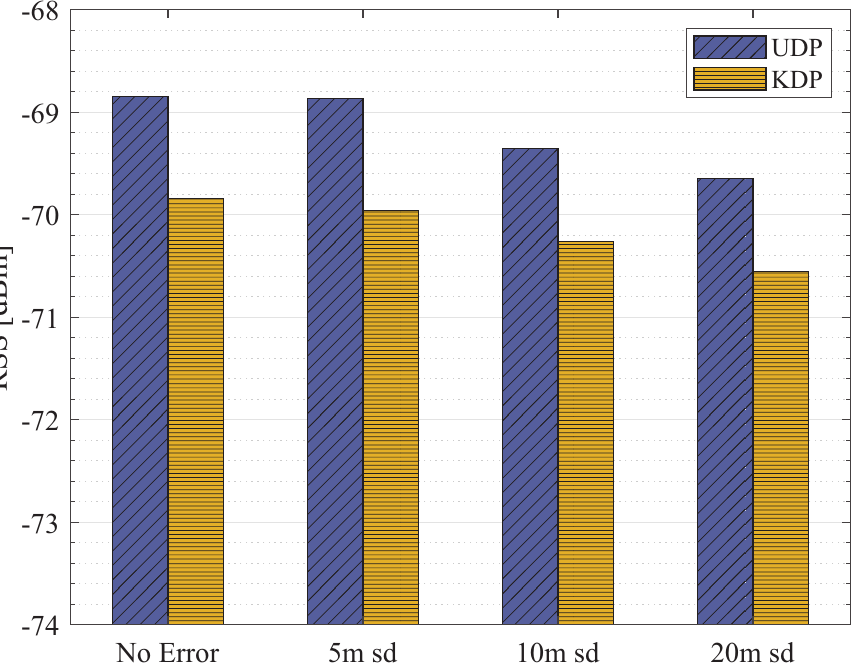
Figure 9. Impact of the increased localization inaccuracy on the achieved average RSS value for the UDP and KDP scheme, given the deployment of 5